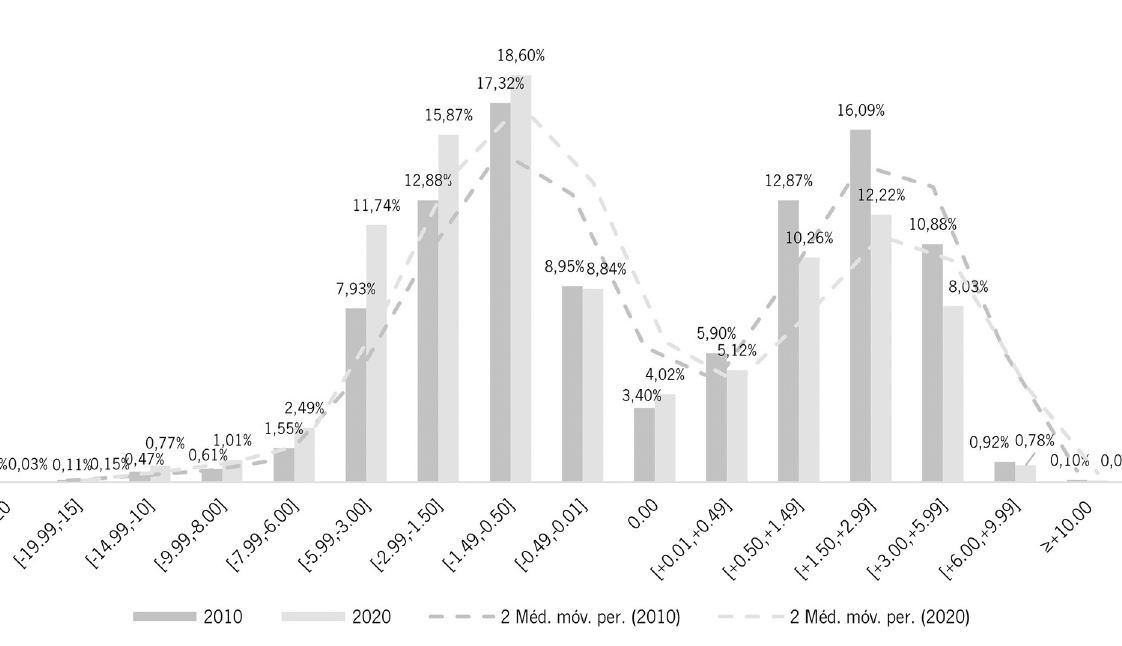
Fig 5. Trends in the distribution of ophthalmic prescriptions in Portugal from 2010 to 2020 according to single vision ophthalmic lenses prescriptions.